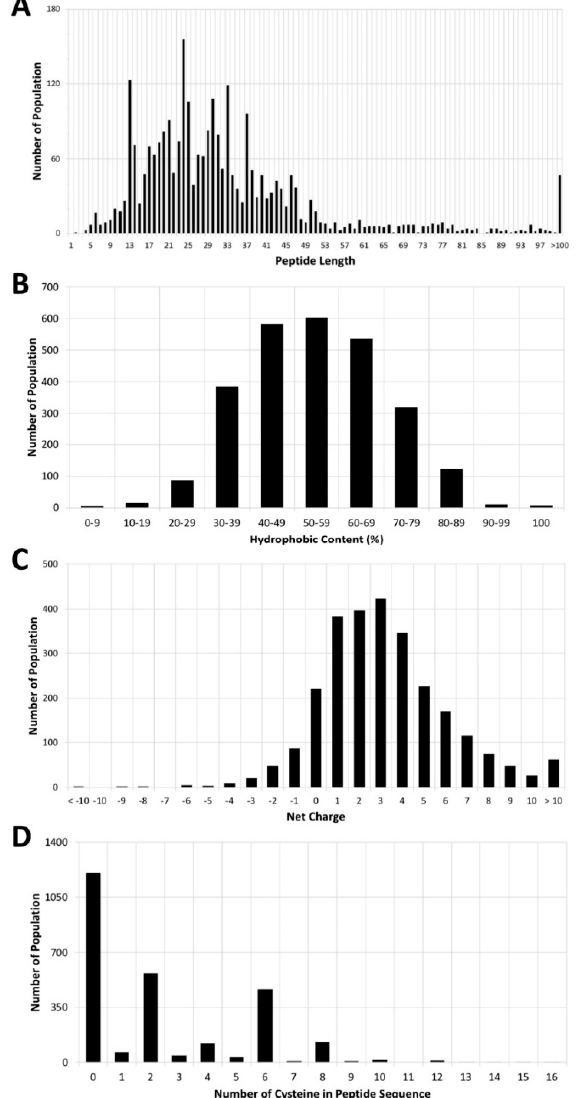
Figure 3. Analysis of Antimicrobial Peptide Database (APD). This analysis took into account 2700 of the AMPs listed in the APD. Distributions of ( A ) peptide length, ( B ) hydrophobic content, ( C ) net charge, and ( D ) number of cysteine residues in the peptide sequence. The raw data were collected from the APD [13].